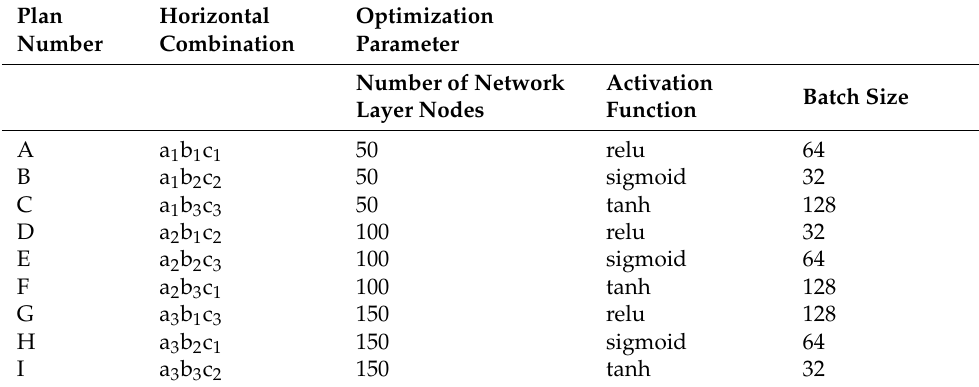
Table 11. The scheme of orthogonal